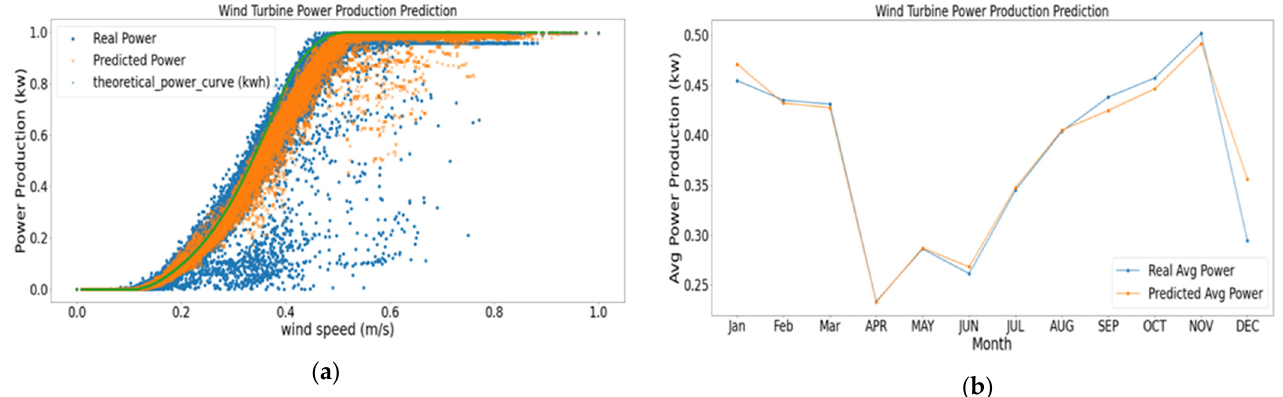
Figure 12. ( a ) Scatter plot depicting the relationship between the wind speed (m/s) and the power produced (kW) when using k-nearest neighbor regression. ( b ) Predicted average power in comparison with real average power (kW) when using k-nearest neighbor regression.